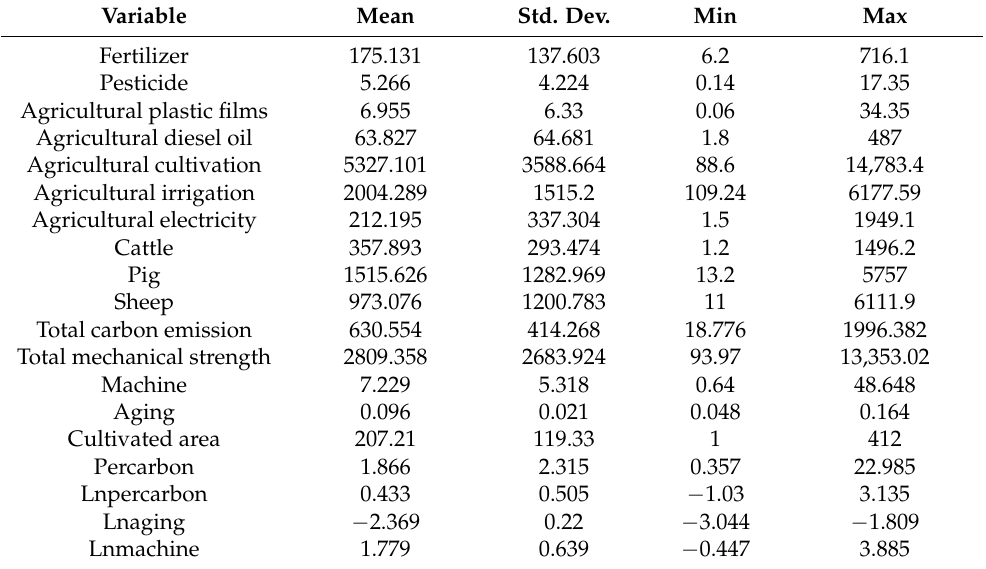
Table 3. Descriptive statistics for primary